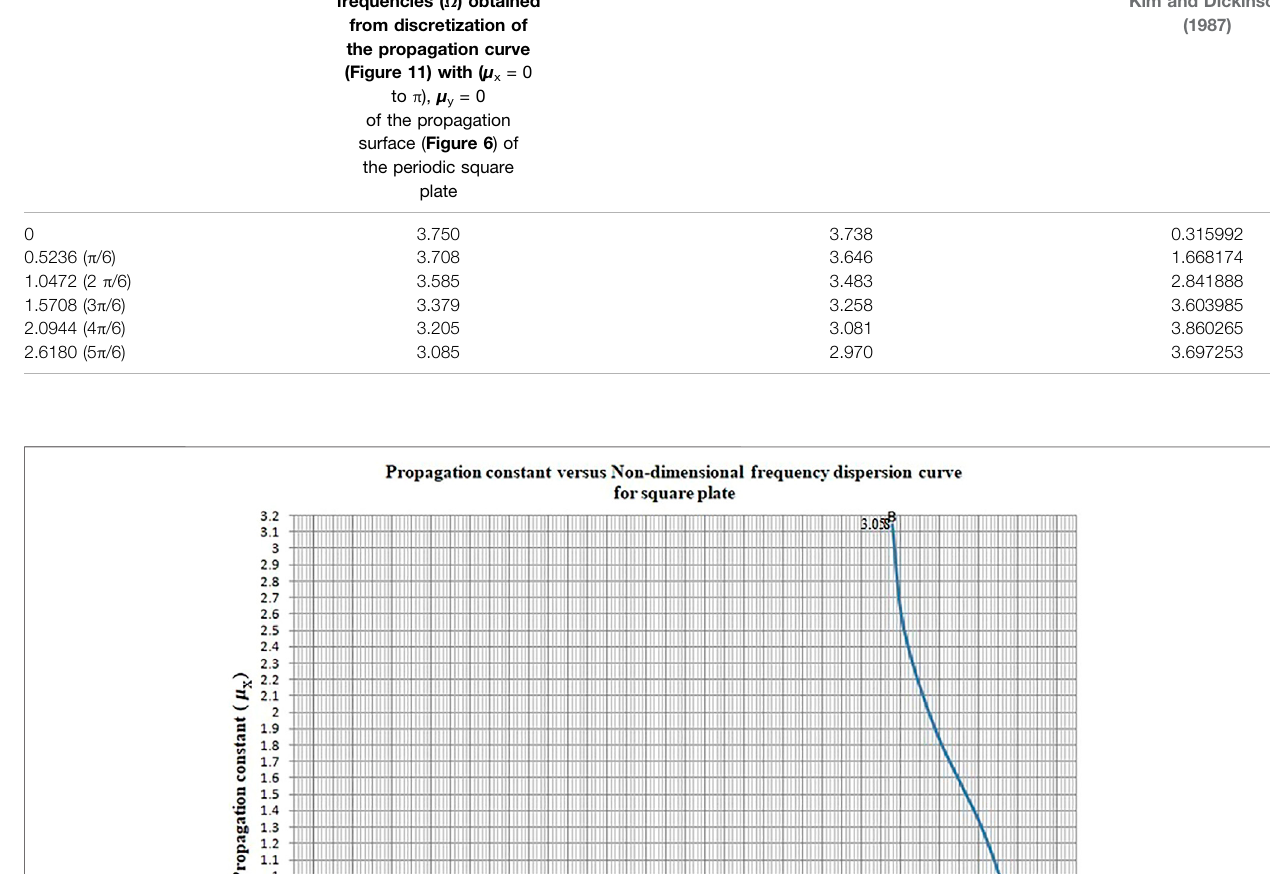
frequencies ( Ω ) obtained from discretization of the propagation curve (Figure 11) with ( μ x = 0 to π ), μ y = 0 of the propagation surface ( Figure 6 ) of the periodic square plate